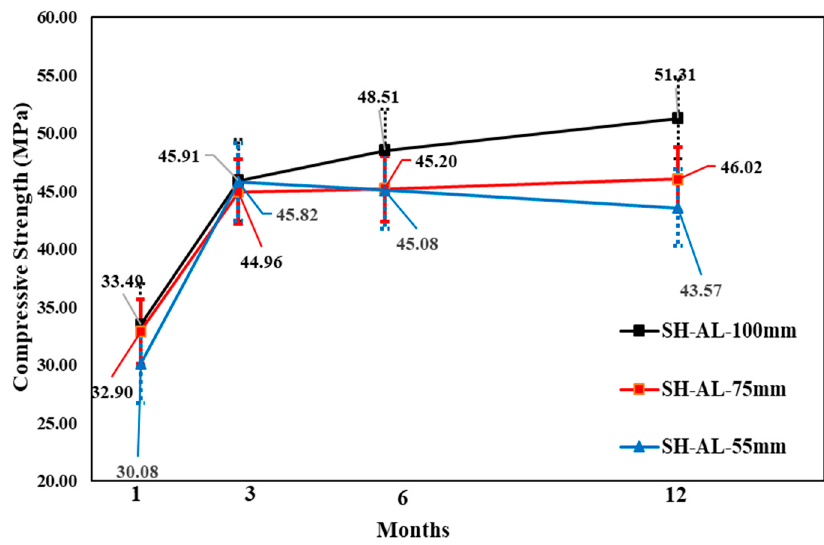
Figure 12. Core compressive strength of aluminate accelerator mix by age.